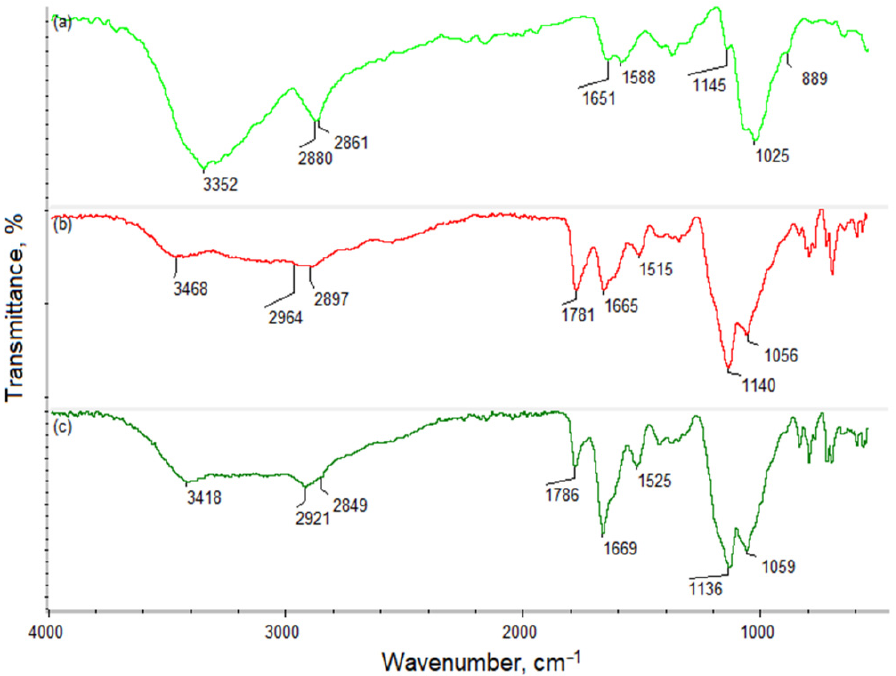
Figure 1. FT-IR spectrum of: ( a ) native chitosan; ( b ) chitosan treated with TFA/DCM 7:3 (sample 1); ( c ) TFA/DCM 9:1 (sample 2).